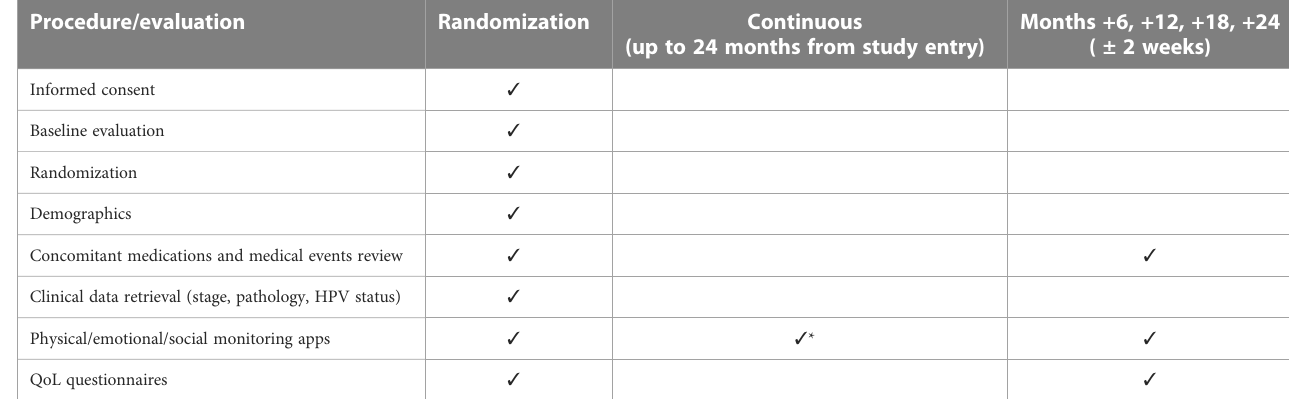
Table 4: at randomization; +6 months ± 2 weeks from randomization; +12 months ± 2 weeks from randomization; +18 months ± 2 weeks from randomization; +24 months ± 2 weeks from randomization.